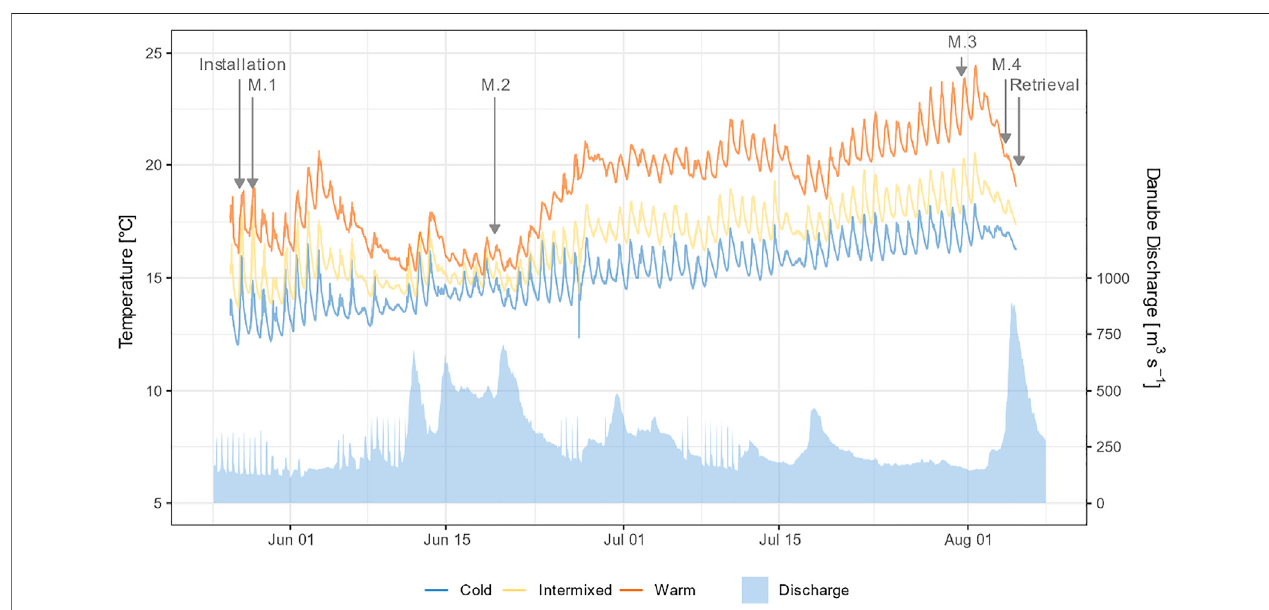
FIGURE 3 | Mean water temperature of the three thermal regions over the study period generated from logger data. Hydrograph of the Danube measured at the nearest water gauge Neuburg a.d. Donau (Bayerisches Landesamt für Umwelt, 2020).